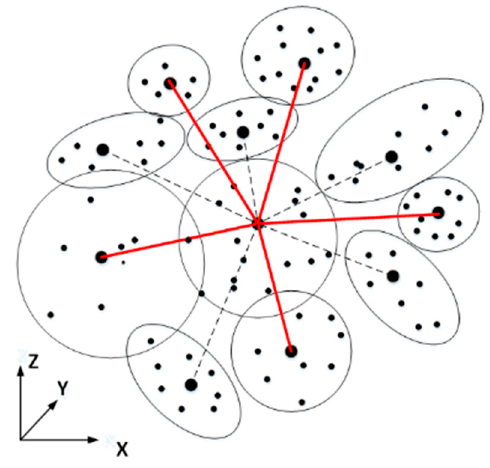
Figure 6. Schematic diagram of optimal neighborhood